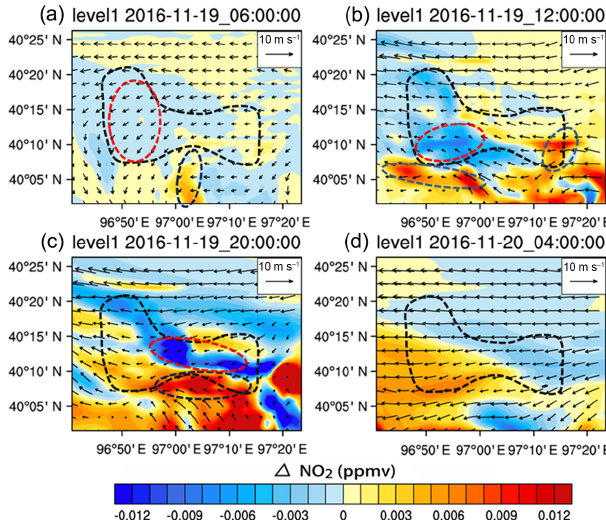
Figure 5. Same as Fig. 3 but for the roughness change parameteri- zation (S2) using the roughness length parameterization. The white star stands for the model grids within the wind farm (44, 52) and outside the wind farm (44, 48) for subsequent discussions (Fig. 9).